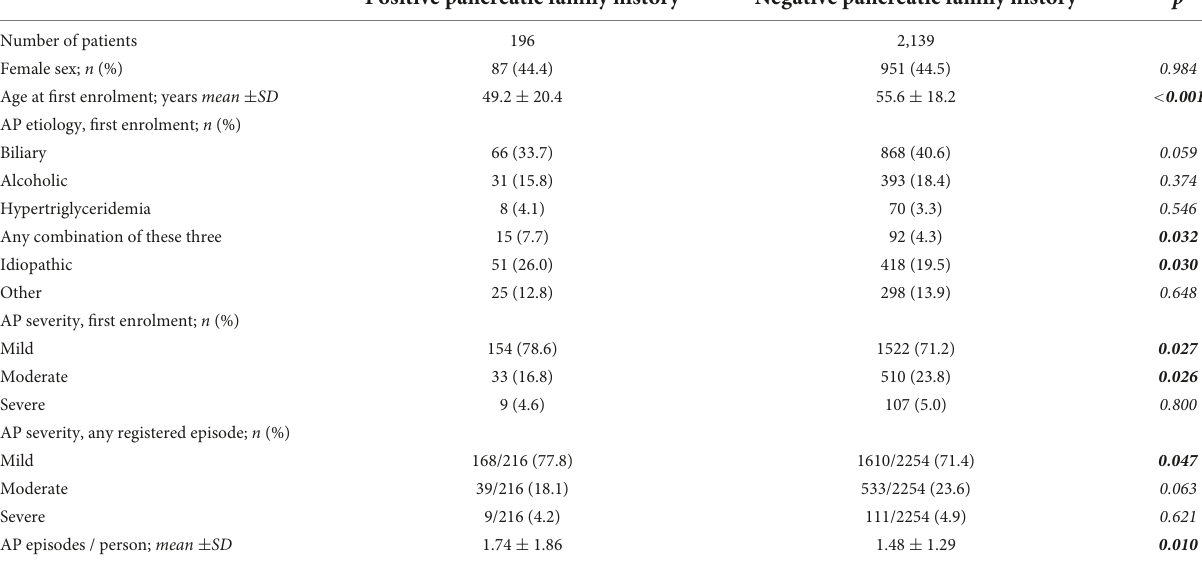
Positive pancreatic family